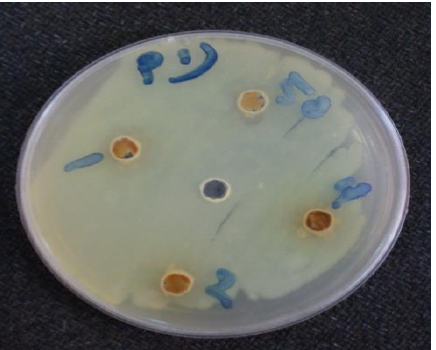
Figure, 6: Inhibition zones of Proteus spp. growth on Mueller-Hinton agar produced by ethanolic extract of Thymus vulgaris , the peripheral four wells contained extract concentrations ( 50, 100, 200, 400 mg/ml) whereas the central well contained 0.1 ml of 96% ethanol .